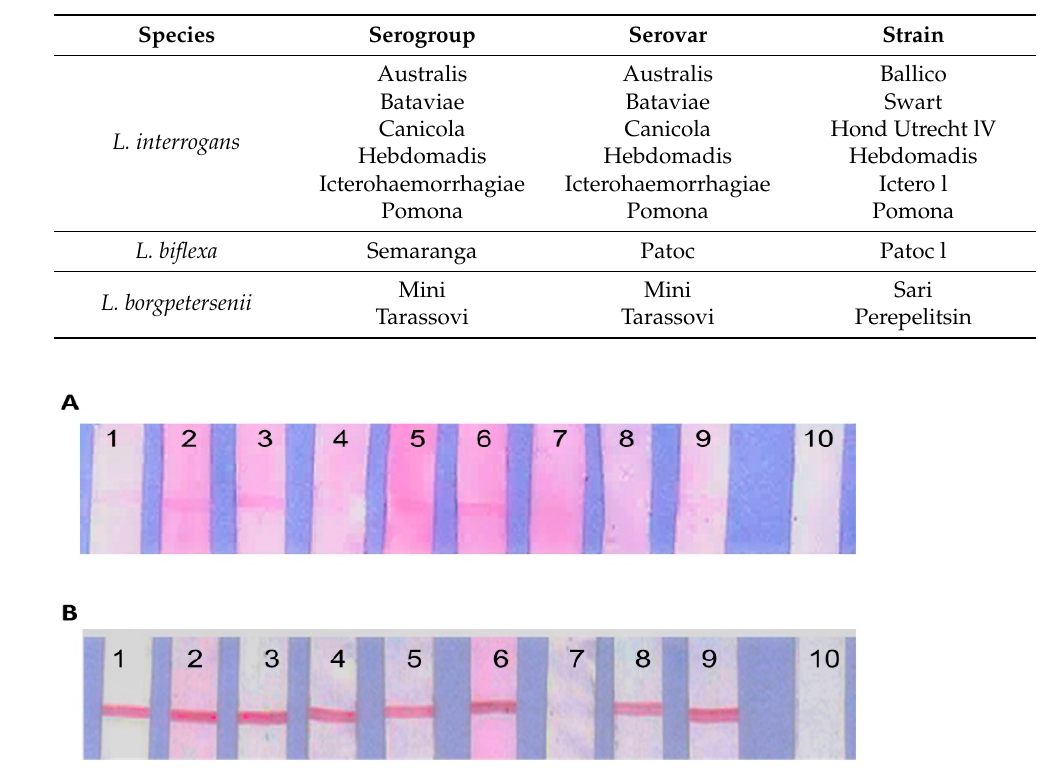
Figure 1. The immunoreactivities of line blot assay between the recombinant